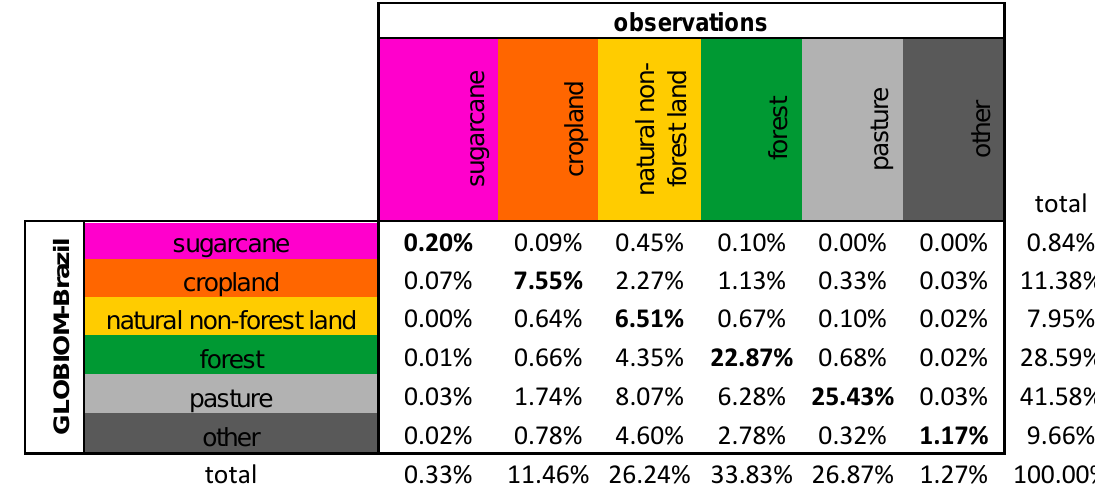
Table 4. Comparison of the modelled LU by the coupled model and the observed LU using the composite operator [36].